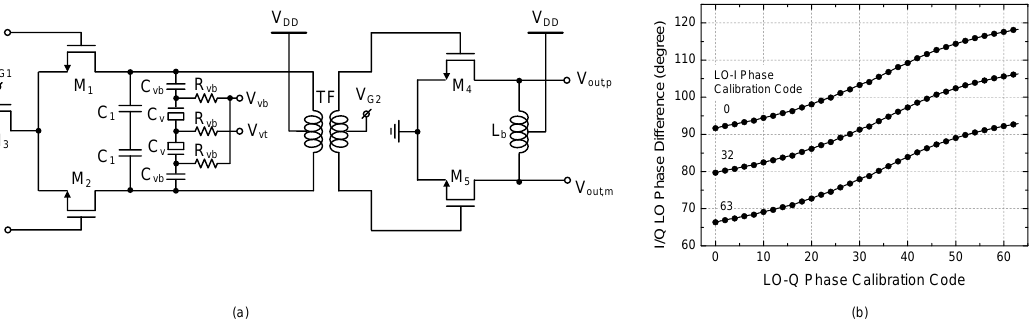
Figure 7. Phase-tunable LO buffer. ( a ) Schematic; ( b ) Phase tuning simulation result.